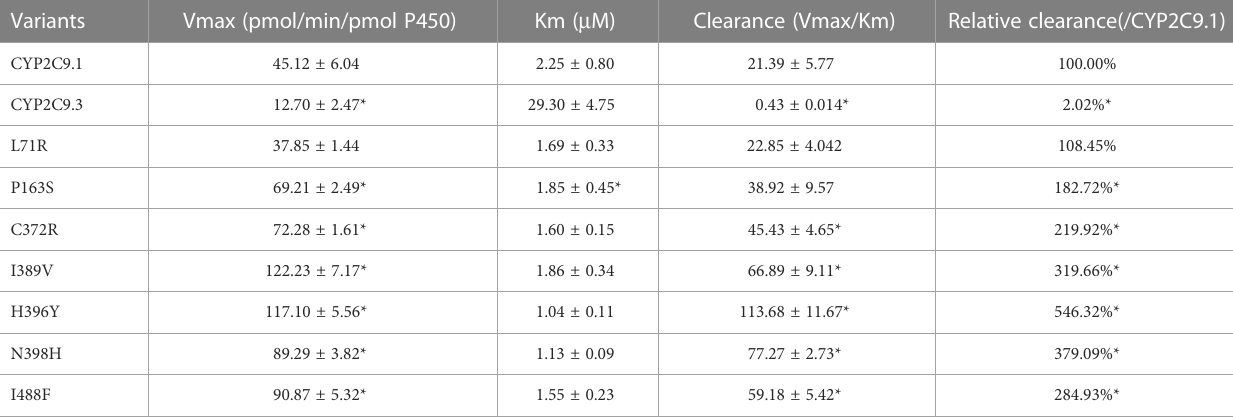
TABLE 6 Enzyme kinetic values of recombinant wild type and CYP2C9 variants towards glimepiride. Variants